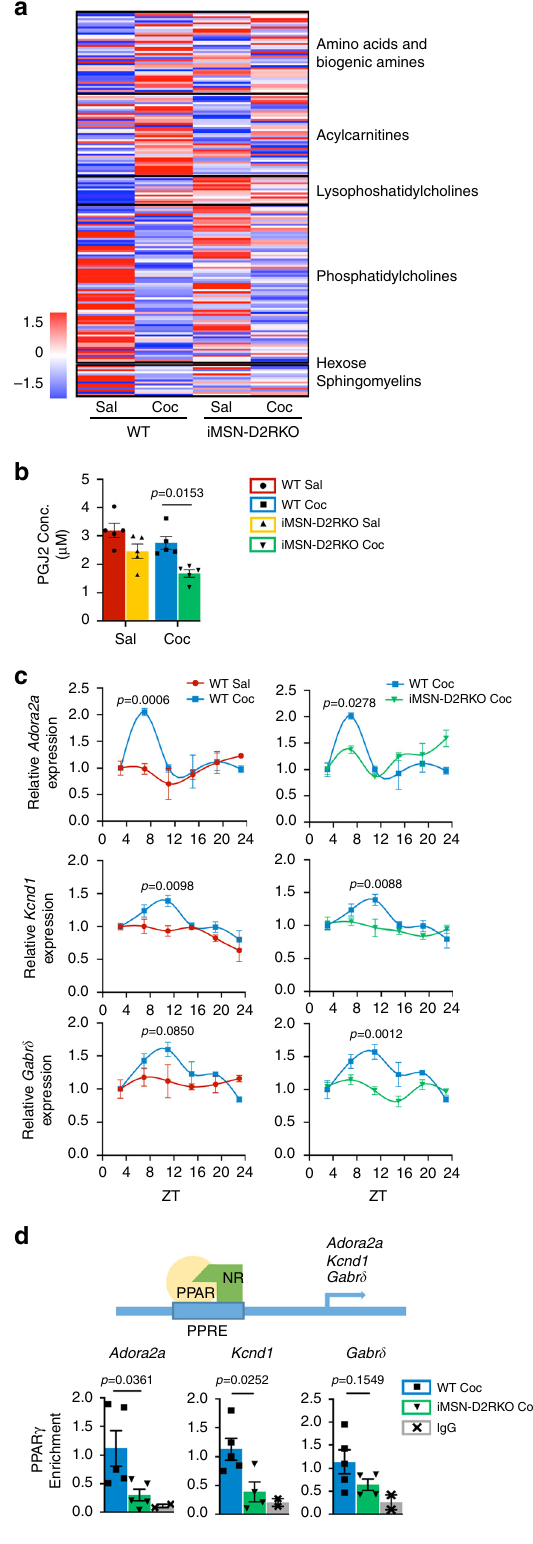
Rescue of PPAR γ function using the speci fi c agonist pioglita- zone . To validate the critical role played by PPAR γ in D2R signaling-dependent circadian reprogramming upon cocaine, WT and iMSN-D2RKO mice were subjected to oral gavage with pioglitazone, a speci fi c PPAR γ activator 51 that crosses the blood brain barrier 52 . Pioglitazone or vehicle, were administered at ZT1, 2 h before the acute cocaine injection (Fig. 7a). Expression of the Adora2a , Kcnd1 and Gabr δ genes was analyzed at ZT7 and at ZT19 (Fig. 7b). Pioglitazone treatment before cocaine reestab- lished the induction of Adora2a ( p = 0.0388), Kcnd1 ( p < 0.0001), and Gabr δ ( p = 0.0019) gene expression in iMSN-D2RKO mice at ZT7, which nicely paralleled WT expression levels (Fig. 7b). Thus, PPAR γ activation operates as a direct link between cocaine, D2R- signaling 42,43 and downstream gene expression (Fig. 7c). These results identify PPAR γ as a critical factor that intervenes in the transcriptional reprogramming of the striatal clock upon acute cocaine treatment.